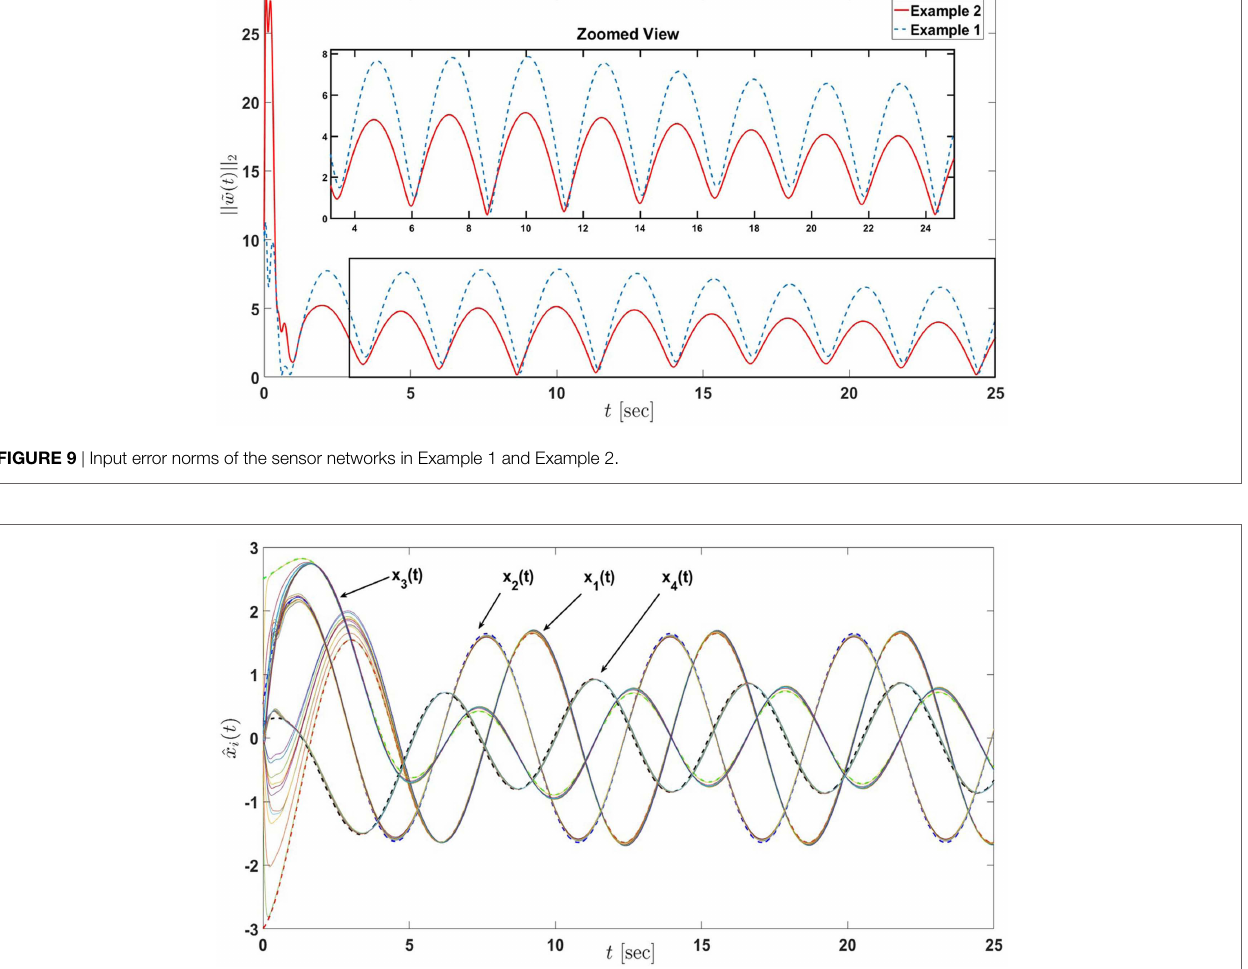
FIGURE 10 | State estimates of the sensor network in Example 3 with 12 active nodes under the proposed architecture equations (7) and (8) (the dash lines denote the states of the actual process and the solid lines denote the state estimates of nodes) Tran et al. (2017).